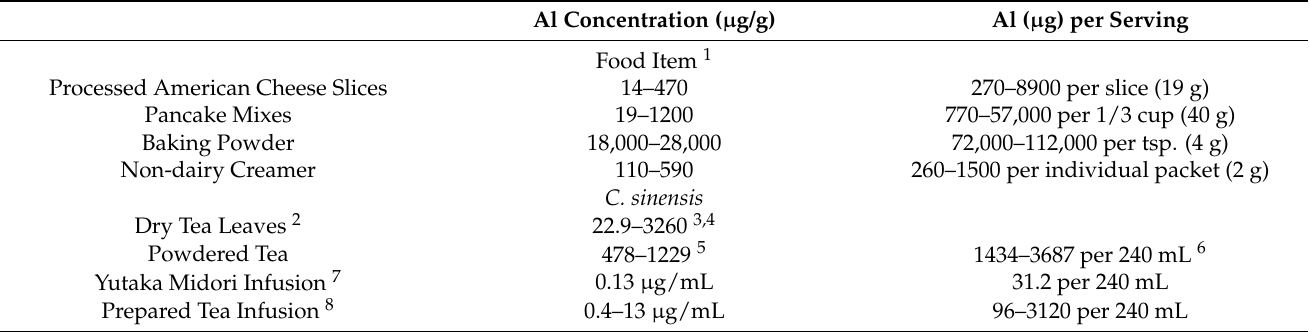
Figure 2. Seasonal comparison and correlation of average Al concentrations and tea leaf positions. Leaf positions 7 and 9 were not part of the original sampling scheme since they were known to be older than the leaves typically harvested (see Sample Collections). Table 1. Comparison of Al Content in food products and C. sinensis.